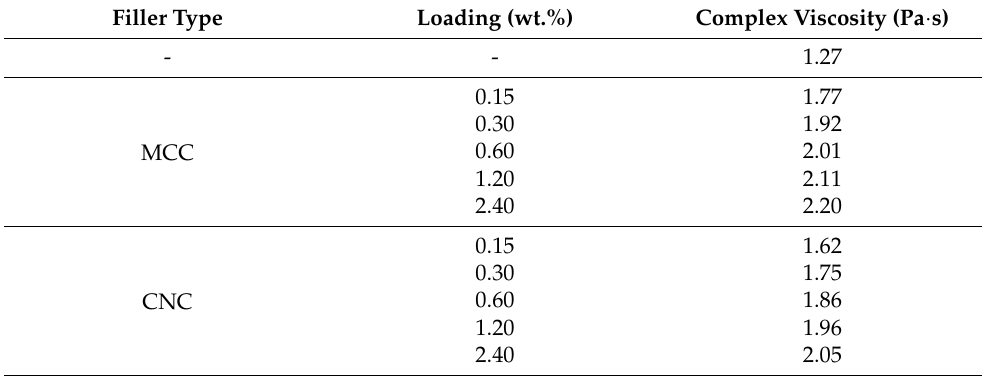
Table 4. Complex viscosity values of the UV-curable systems as a function of the filler loading in